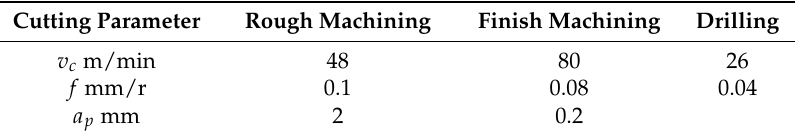
Table 6. Cutting parameters.